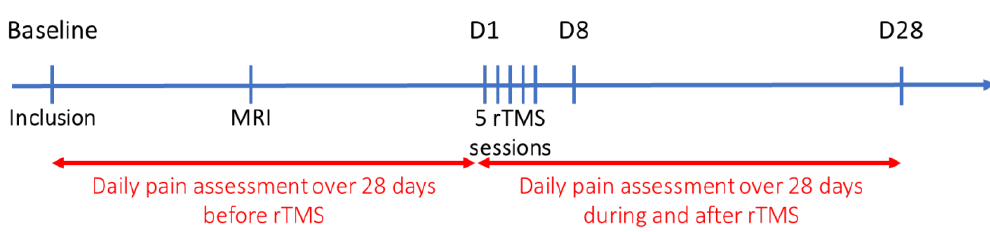
Figure 1. Overview of the protocol. rTMS: Repetitive transcranial magnetic stimulation; D1: day 1; D8: day 8; D28: day 28. MRI: magnetic resonance imaging.